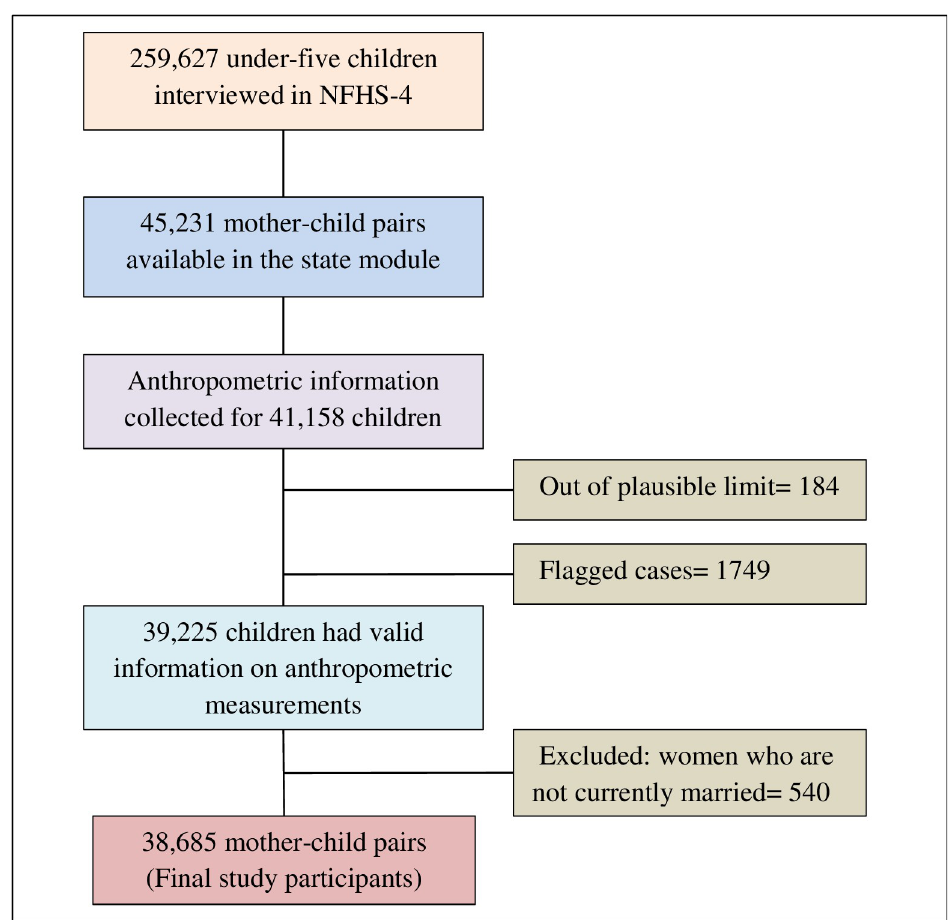
Fig 1. Flow chart showing the selection of study participants, NFHS-4